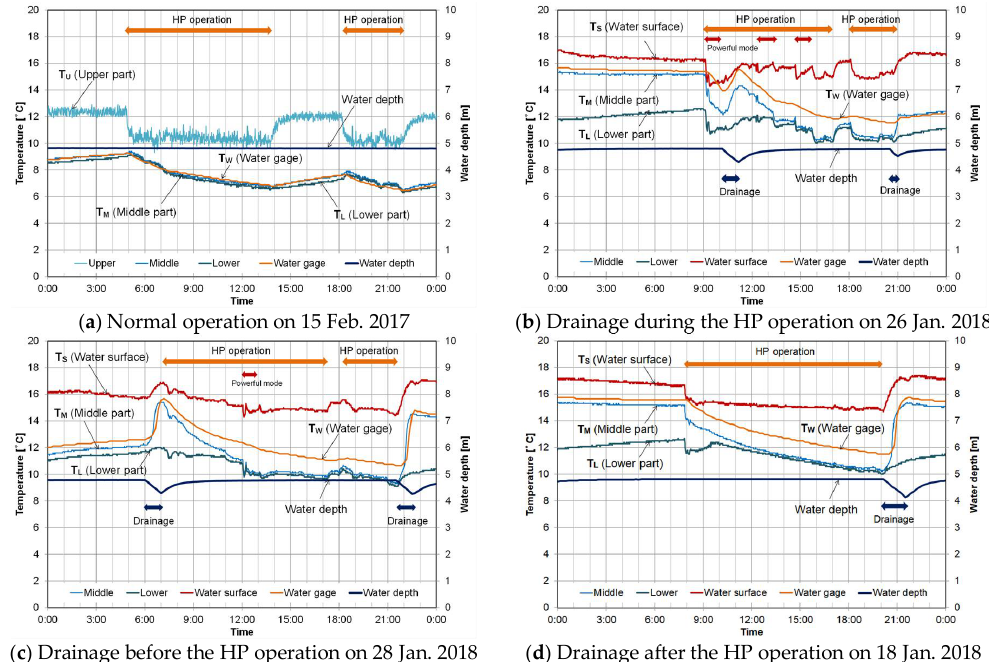
Figure 6. Well-water temperature and water depth changes in each operation